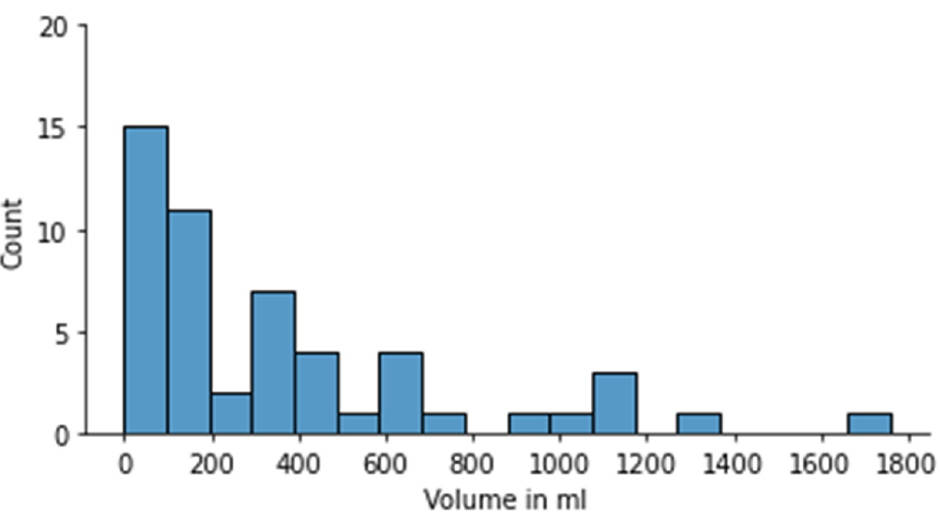
Figure 2. Volumes as assessed by review radiologist.